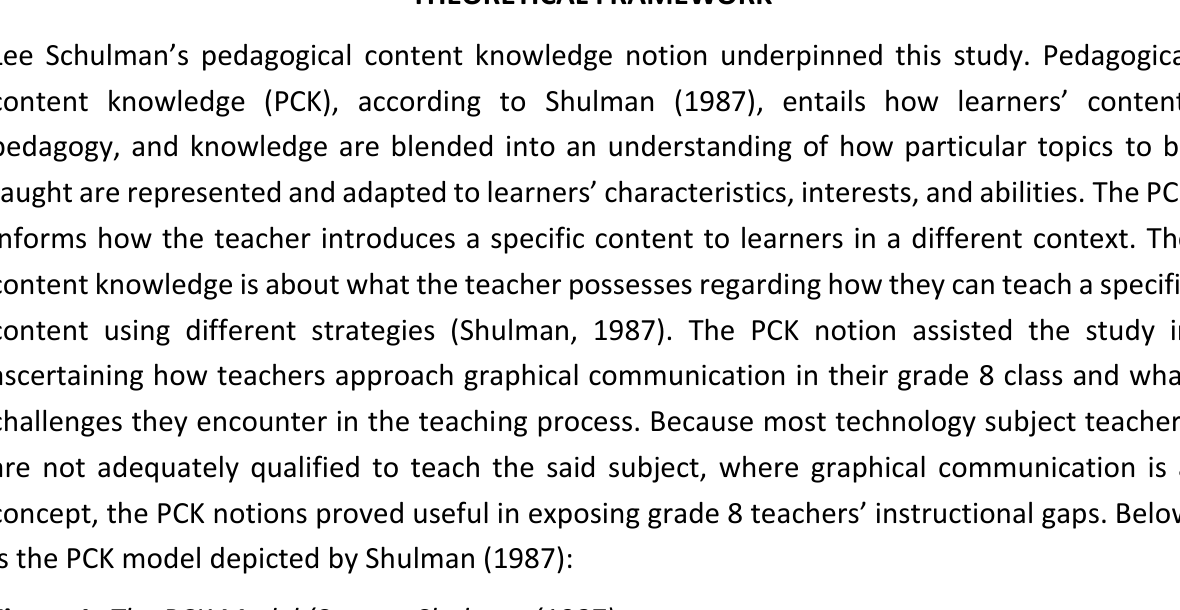
Figure 1. The PCK Model (Source: Shulman